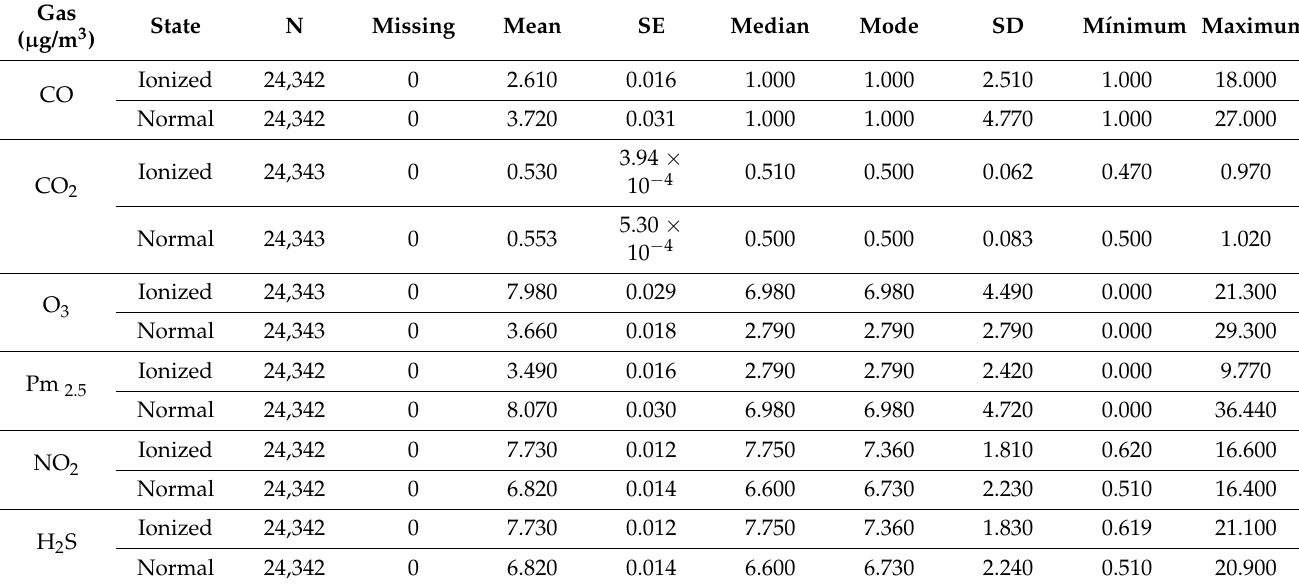
Table 2. Concentration of gases and particulate matter obtained